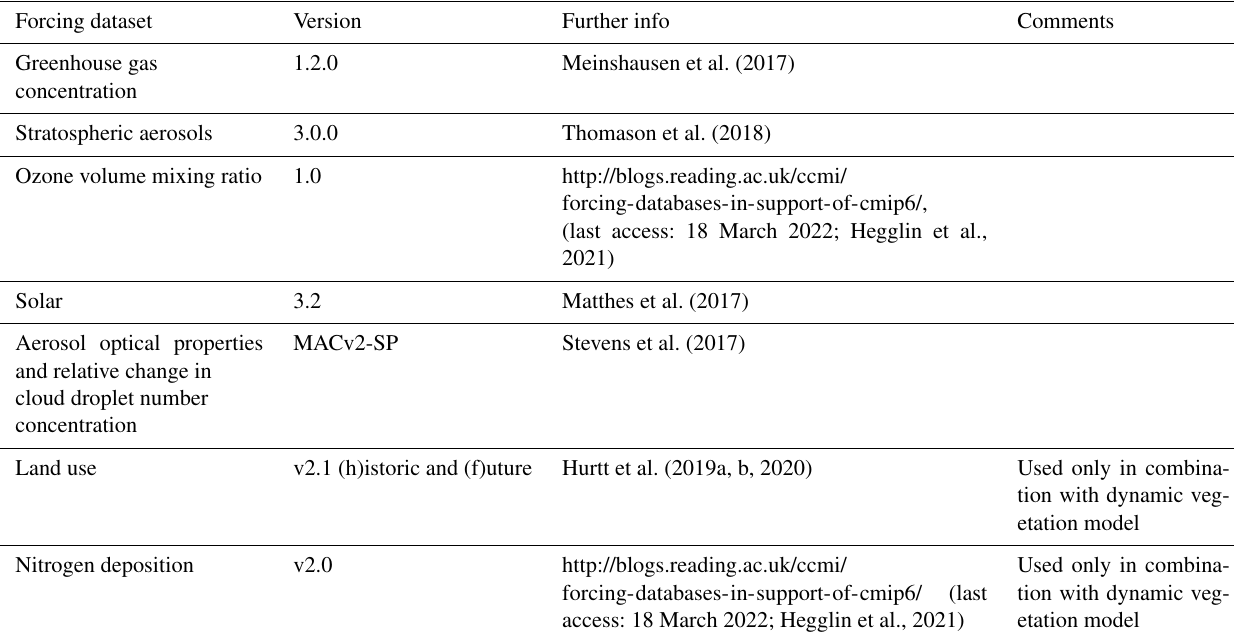
Table 13. CMIP6 forcing datasets used by EC-Earth3 and EC-Earth3-Veg for DECK (diagnostic, evaluation, and characterization of klima) and historical experiments. All datasets are available from https://esgf-node.llnl.gov/search/input4mips/ (last access: 18 March 2022). A more detailed description of the CMIP6 forcing datasets is available at http://goo.gl/r8up31 (last access: 18 March